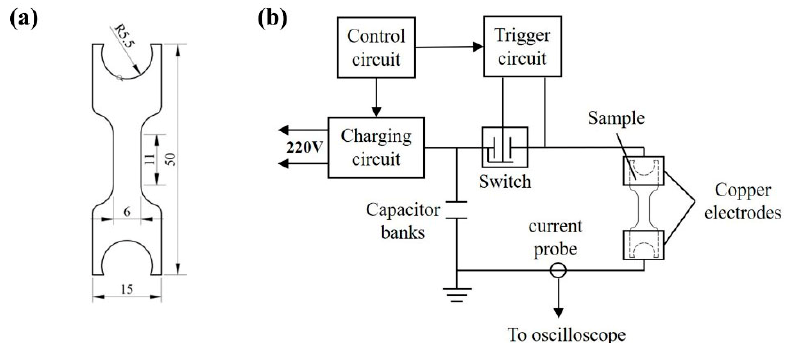
Figure 1. ( a ) The schematic diagram of the sample; and ( b ) the schematic illustration of the ECP experimental equipment. Table 2. The current density, the pulse duration and the corresponding temperature of the samples before and after ECP